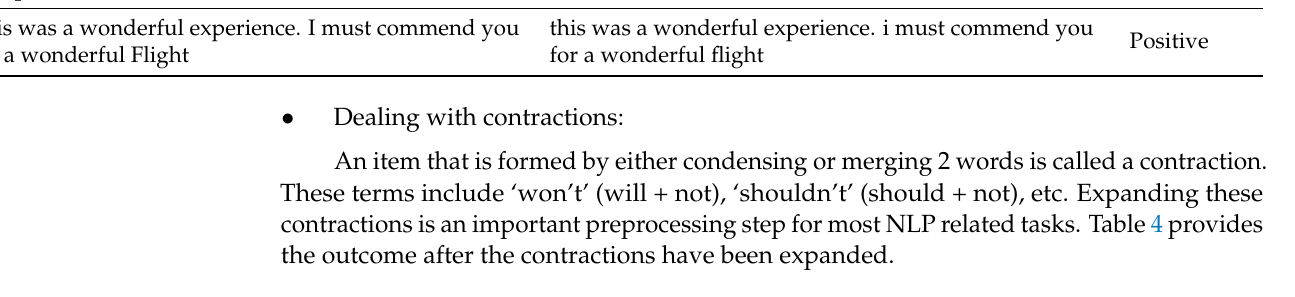
Table 4. Outcome after dealing with contractions.